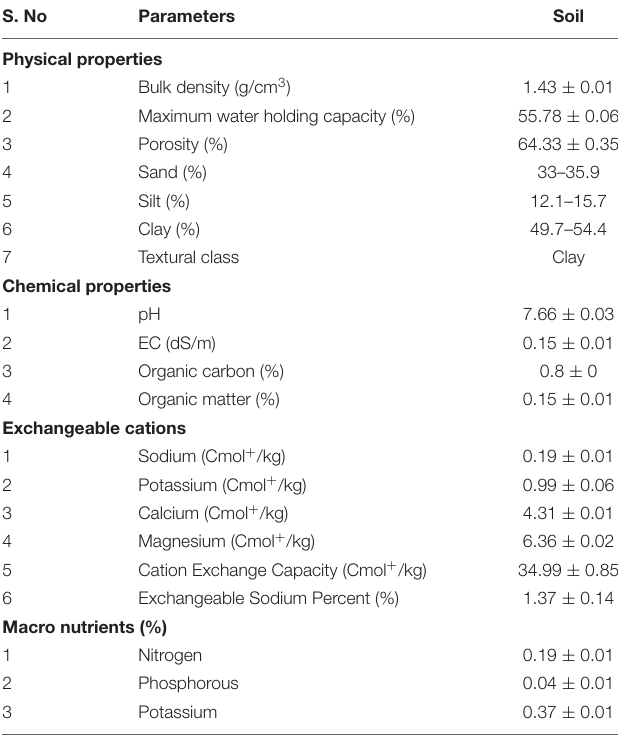
TABLE 4 | Initial physicochemical characterization of soil.